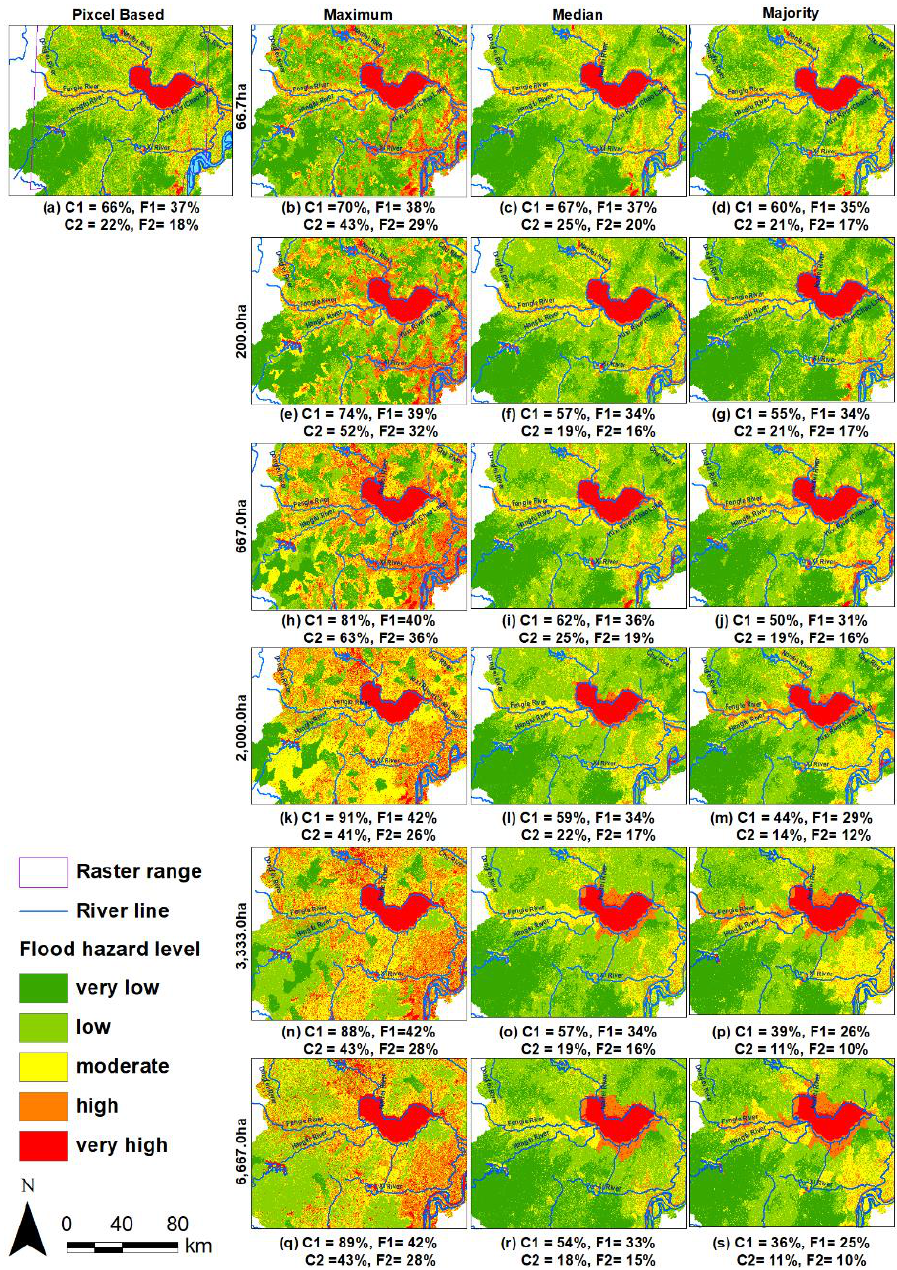
Figure 10. Flood risk levels from pixel-based AHP ( a ) and sub-watershed based AHP using D8- derived sub-watershed to constrain converging related indicators, such as Elevation, Slope and Distance from Streams ( b – s ).